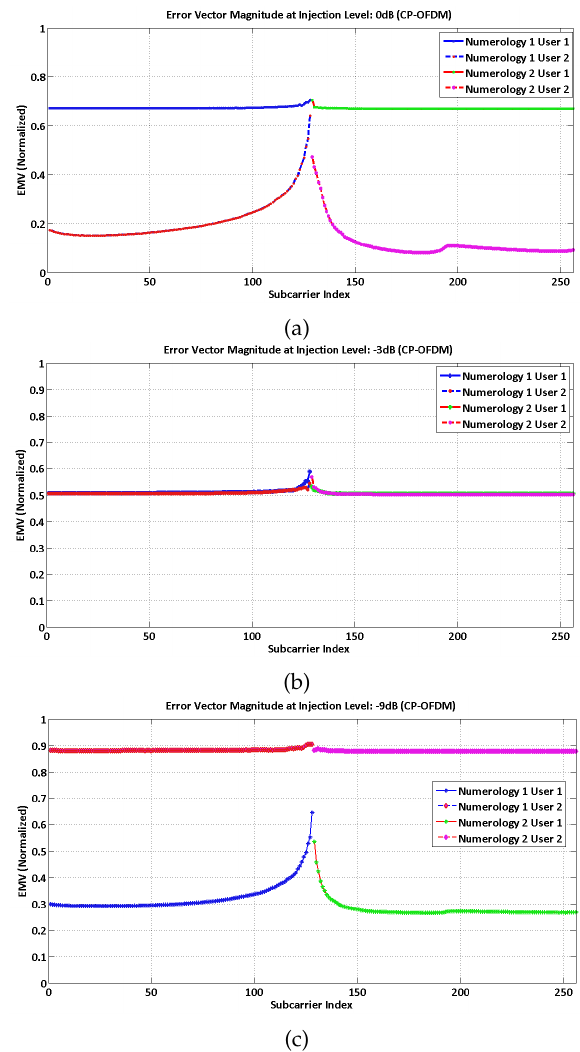
Fig. 5. NOMA Scenario (CP-OFDM) : EVM v/s subcarrier index at an injection levels of (a) 0 dB, (b) − 3 dB & (c) − 9 dB